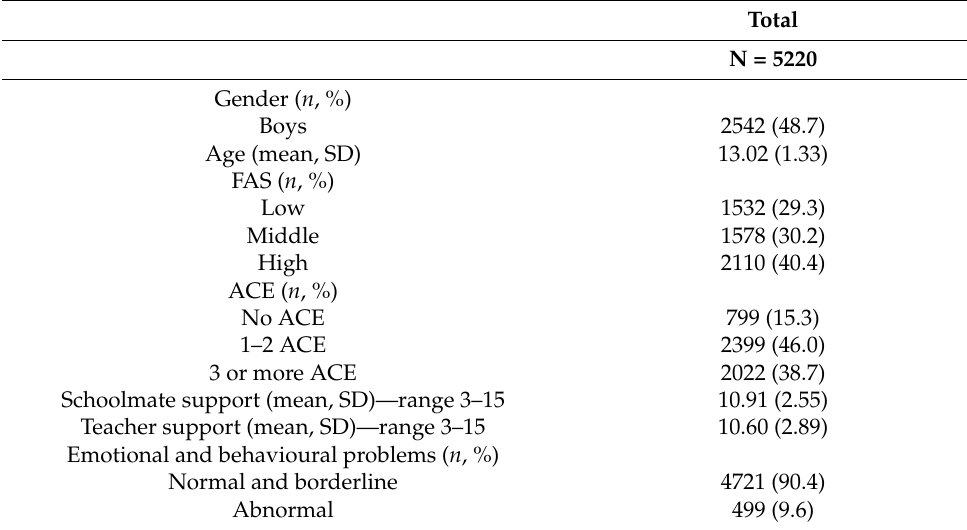
Table 1. Descriptive statistics, Health Behaviour in School-Aged Children study collected in Slo- vakia